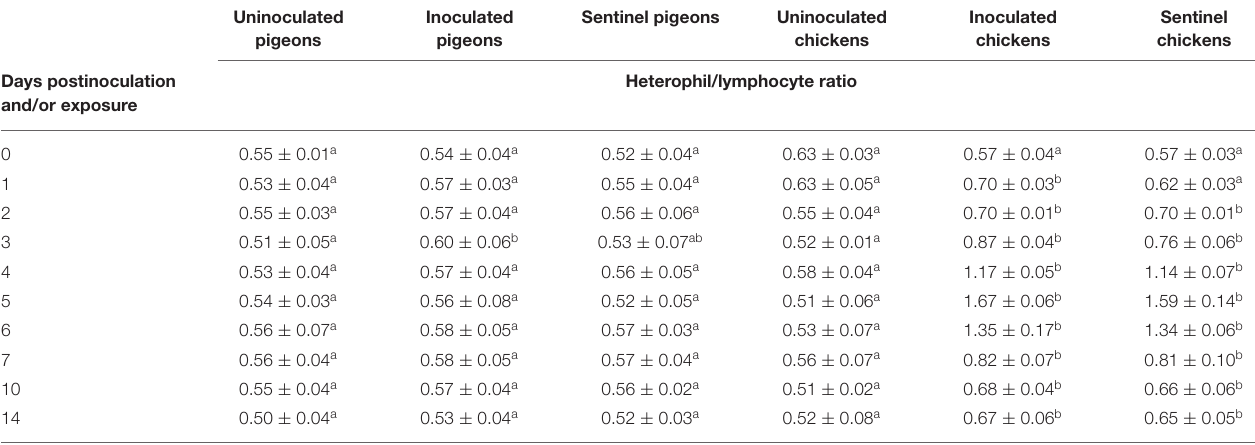
TABLE 7 | Mean heterophil/lymphocyte ratio of pigeons and chickens following inoculation with and/or exposure to a very virulent infectious bursal disease virus.